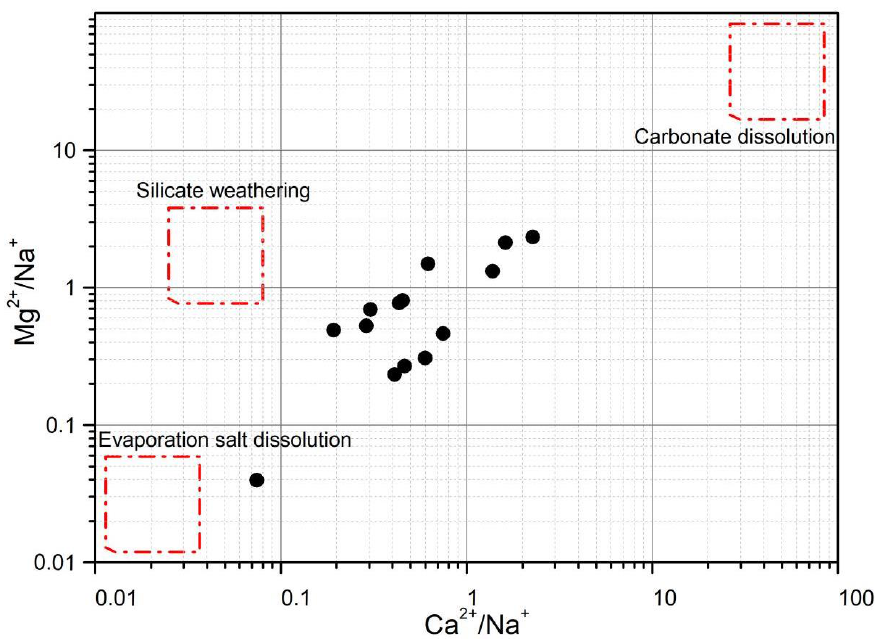
Figure 8. Relationship between Ca 2+ /Na + and Mg 2+ /Na + of phreatic aquifer in Yongqing County.